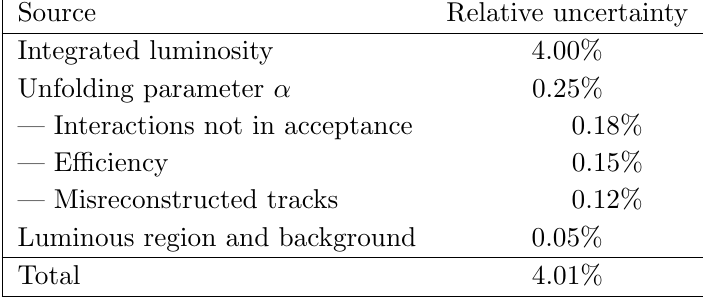
Table 1 . Summary of systematic uncertainties on the (cid:12)ducial cross-section. For the contribution from the unfolding parameter (cid:11) a breakdown into the individual components is given. f X